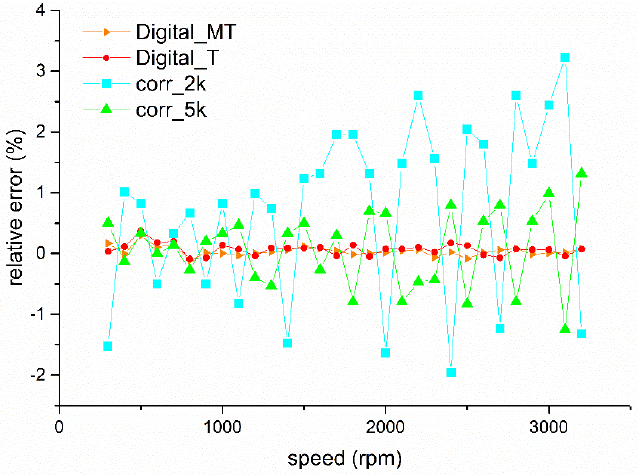
Figure 21. The absolute value of the relative error.